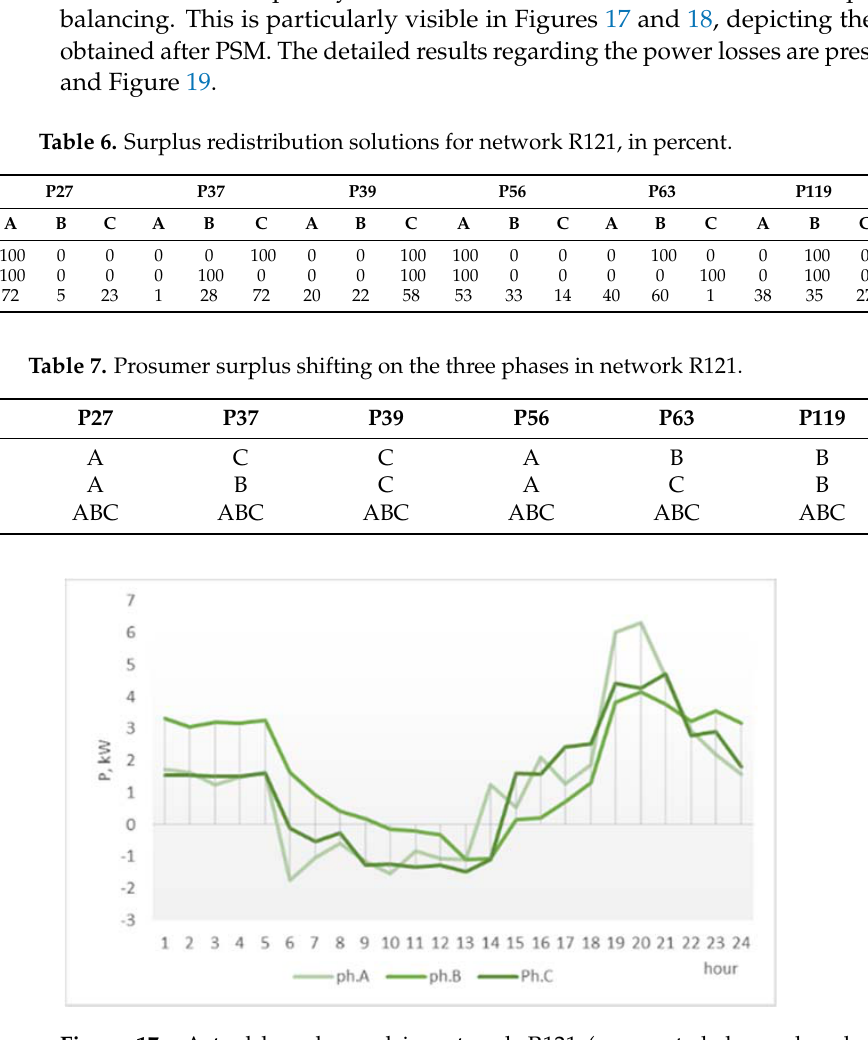
Table 6. Surplus redistribution solutions for network R121, in percent.